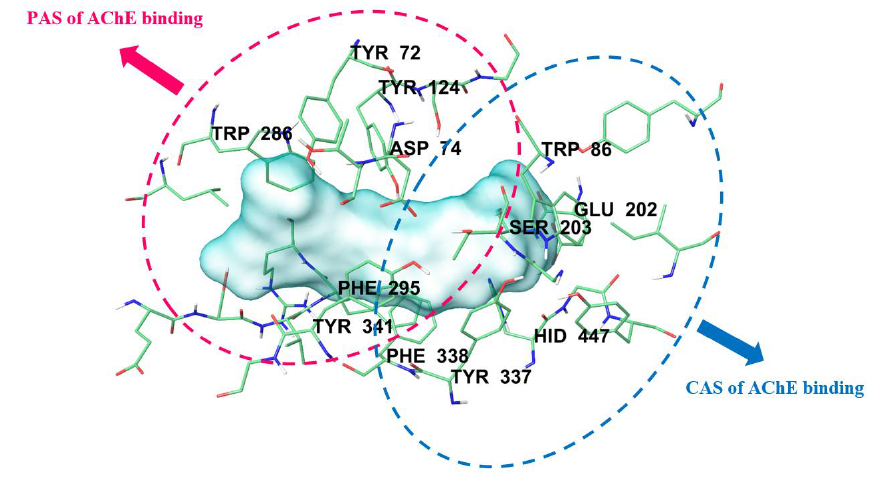
Figure 3. The CAS and PAS regions of AChE enzyme along with the important amino acids.